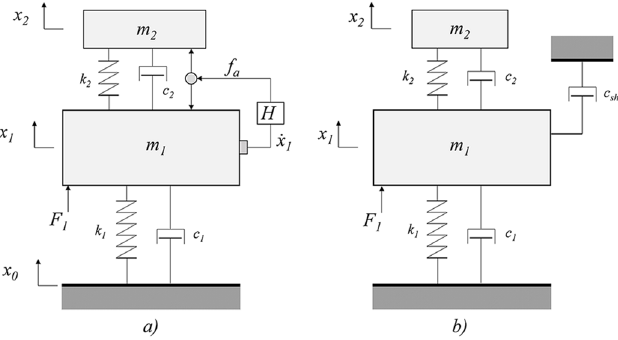
Fig. 1. Schematics of the control unit model used in the simula- tions. a) Hybrid Tuned Mass Damper, b) Passive system (Tuned Mass Damper and Skyhook